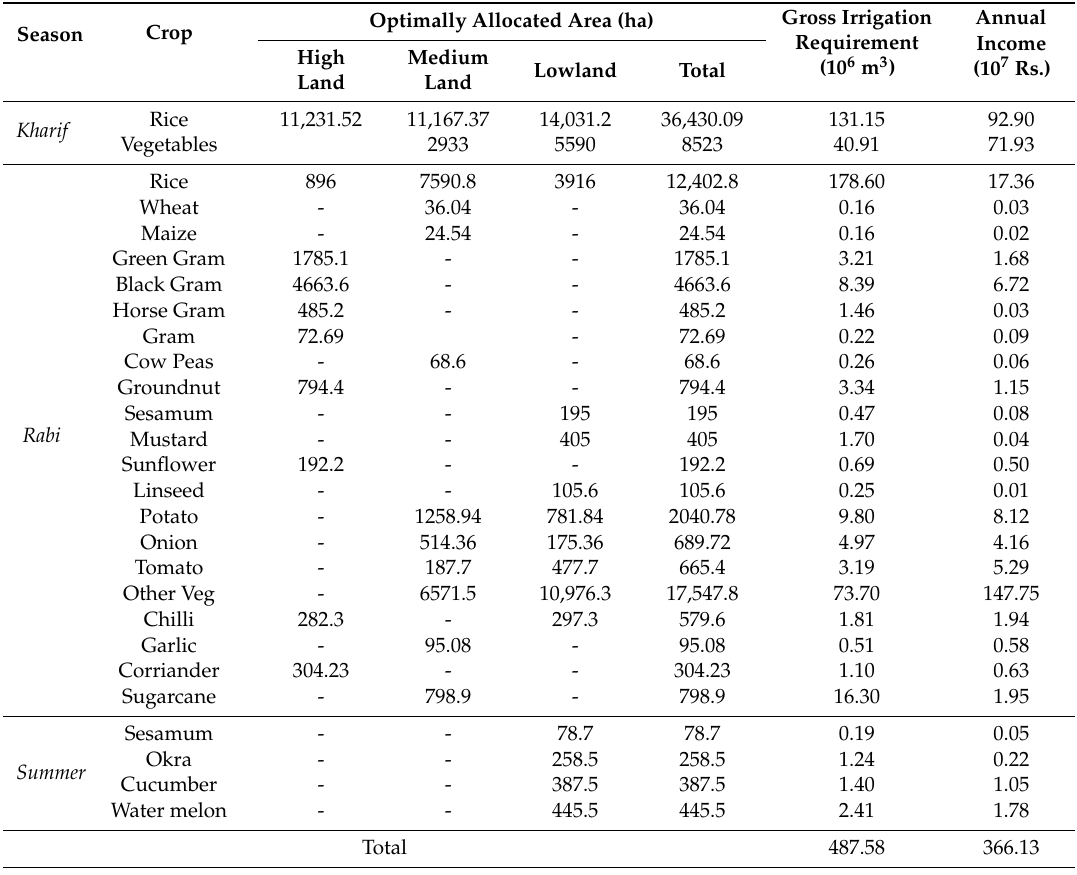
Table 3. Optimal cropping patterns, gross irrigation requirement, and annual income computed by